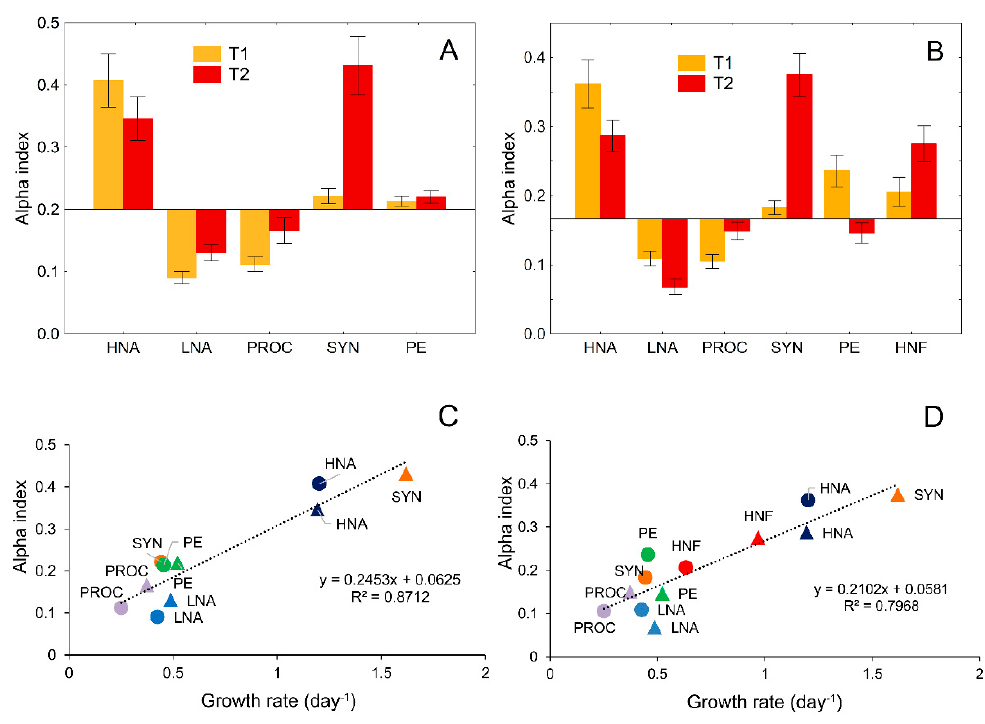
Figure 4. The Manly–Chesson normalized alpha index (mean ± SD) showing a preference or prey selection for HNF ( A ) and ciliate grazing ( B ) at ambient temperature (14 °C; T1) and after a 3 °C rise above ambient temperature (T2). Regression of the prey preference (expressed as alpha index) of HNF ( C ) and ciliates ( D ) to microbial growth rates. Circles represent ambient temperature, and triangles represent 3 °C above ambient temperature. Colors in panels C and D serves to distinguish species pairs at two temperatures (in C and D, standard deviations of the alpha index are the same as in A and B). HNA, high nucleic-acid bacteria; LNA, low nucleic-acid bacteria; PROC, Prochlorococcus ; SYN,